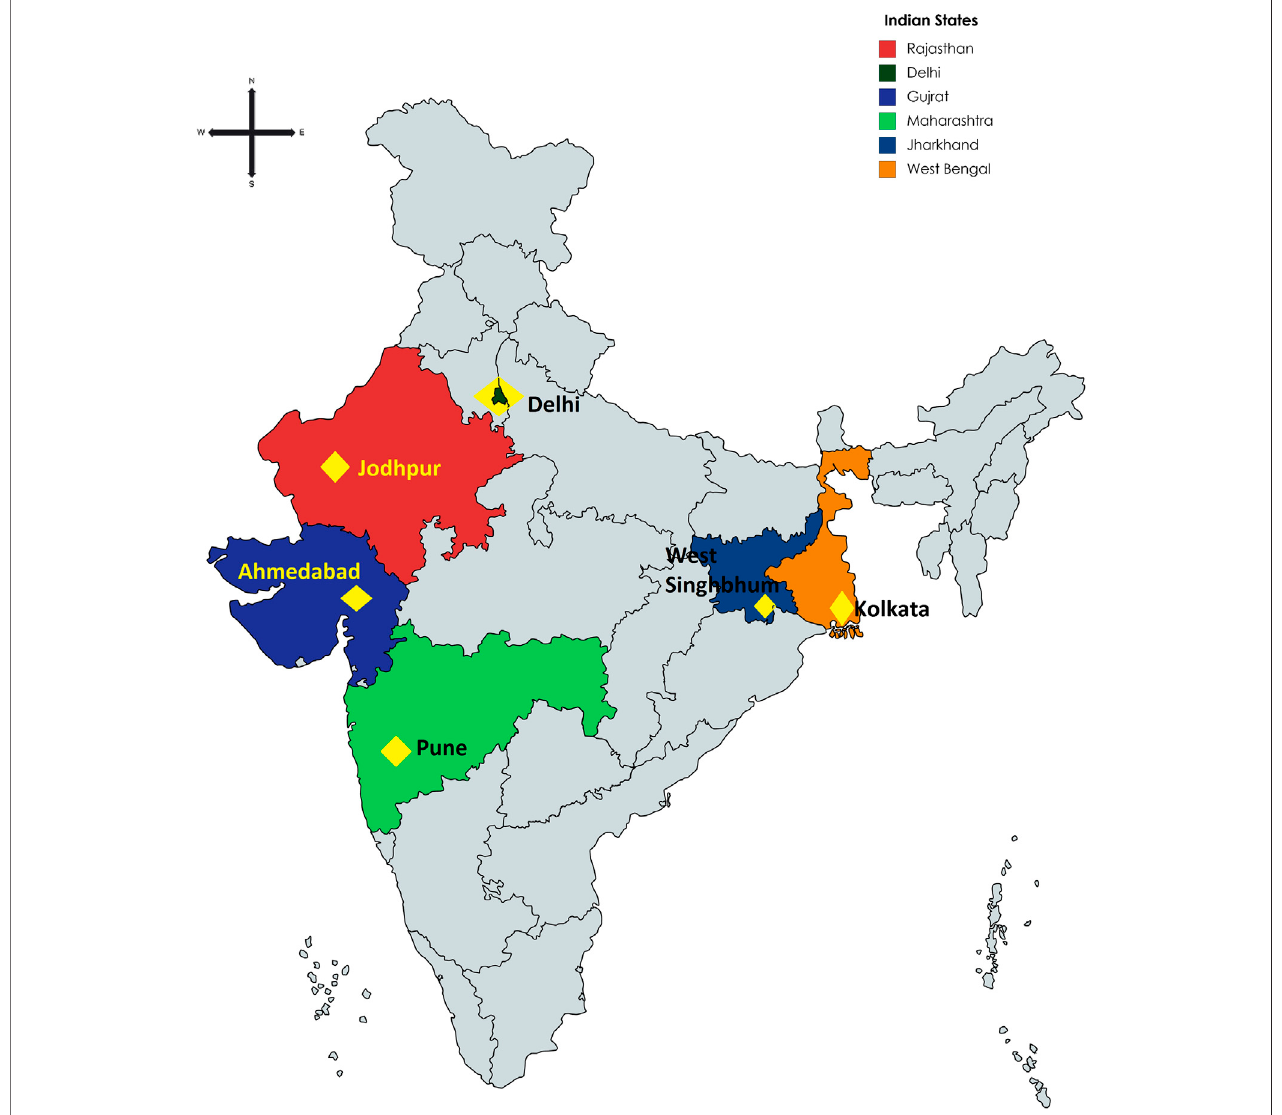
FIGURE 1 | Location of participating pharmacies in